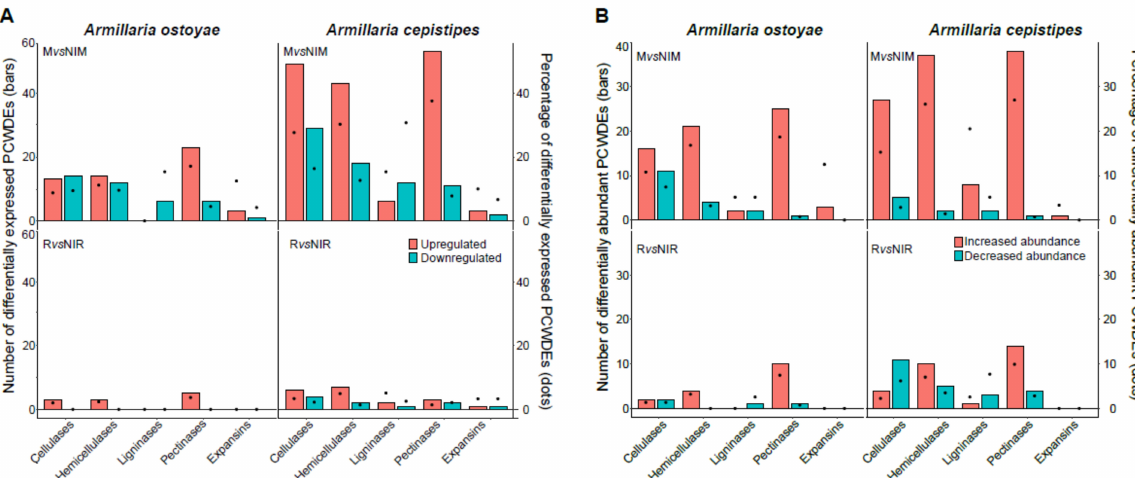
Figure 5. Differentially expressed/abundant plant cell wall degrading enzymes in the two species. ( A ) Barplot showing number, and dots showing the percentage of differentially expressed PCWDEs in the two species in MvsNIM (top) and RvsNIR (bottom) in transcriptomics data. ( B ) Barplot showing the number, and dots showing the percentage of differentially abundant PCWDEs in the two species in MvsNIM (top) and RvsNIR (bottom) in proteomics data. CAZYmes classified on the basis of their substrate in the plant cell wall (Supplementary Table S6) showing the number of genes upregulated/increased abundance (orange) and downregulated/decrease (blue-green) in the two